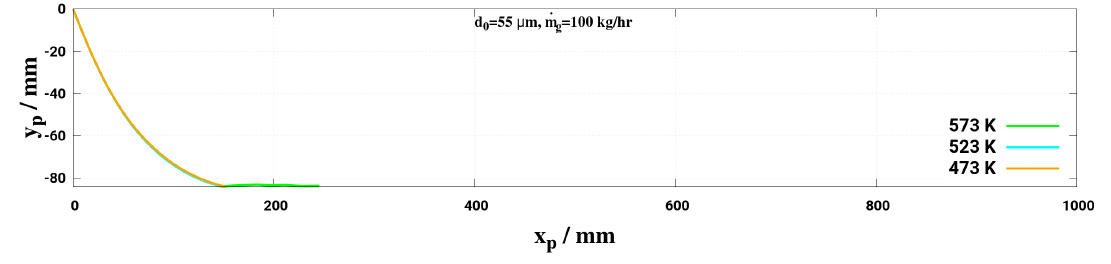
Figure 13. Droplet trajectory and life: deposition case for mass flow rate ˙ m g = 100 kg/h at various gas temperatures of 573 K, 523 K, and 423